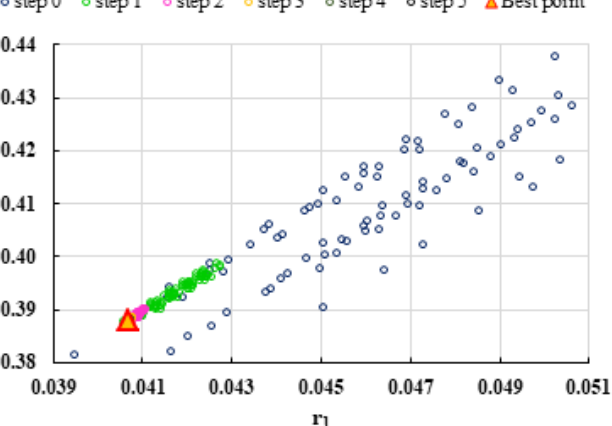
conditions imposed by MC3.